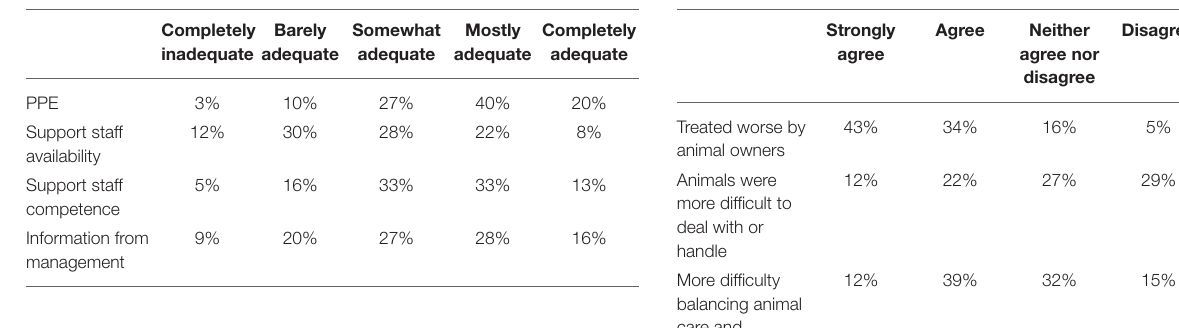
TABLE 4 | Veterinary technicians’ perceptions of their routine, work-specific experiences during